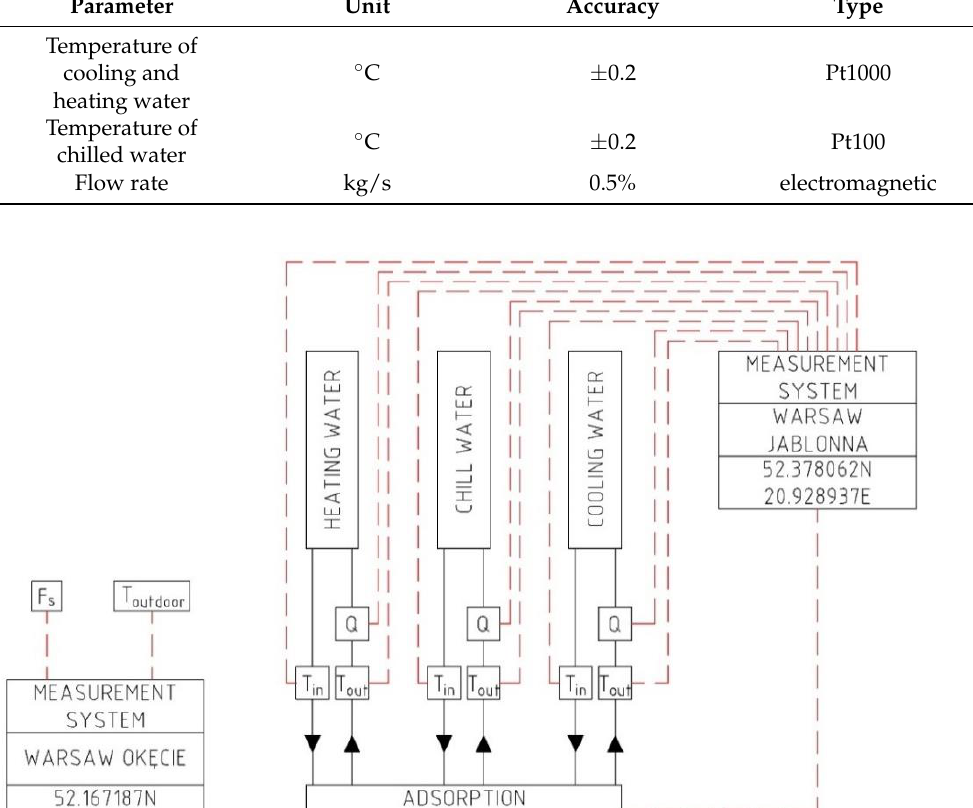
Figure 4. Meteorological data for the Warsaw-Okęcie measuring station compiled on the basis of 30 full measurement years.